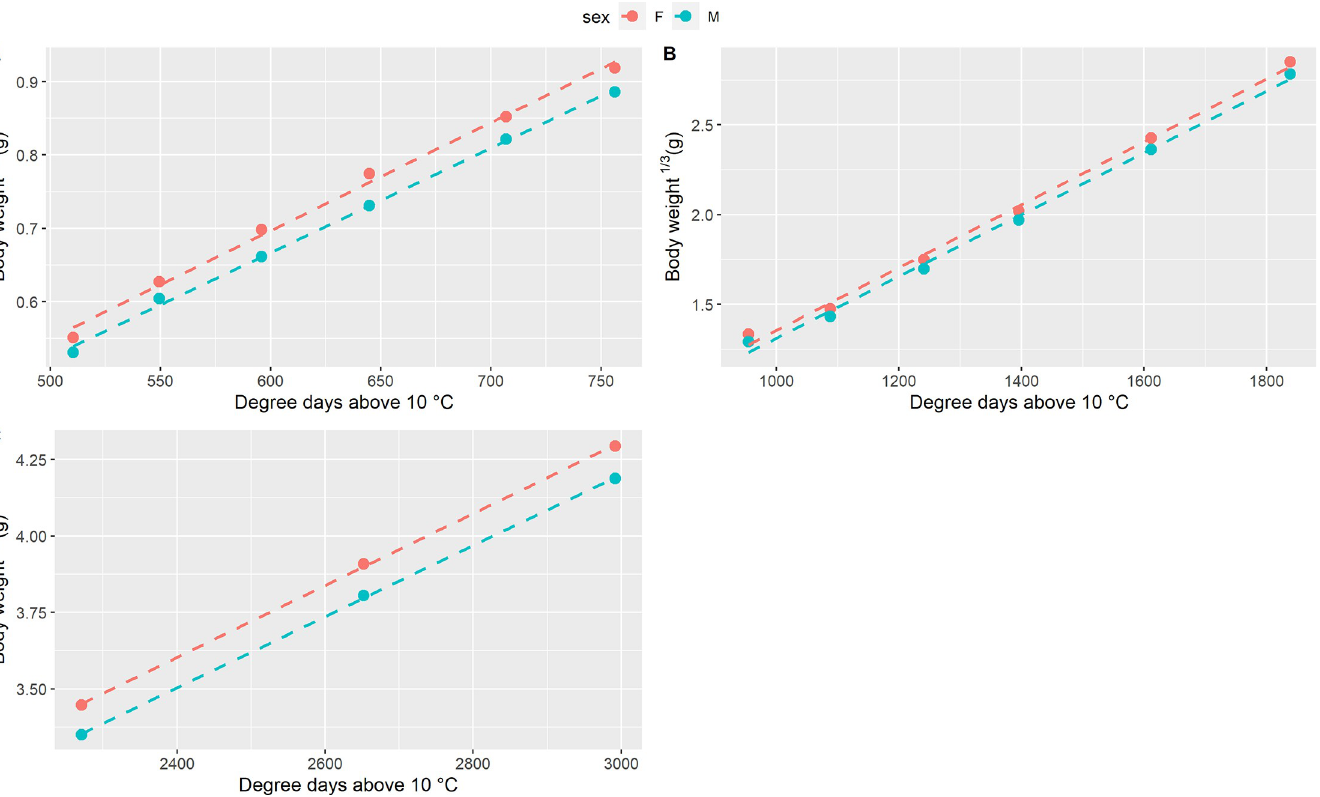
Fig 2. Growth curve for body weight. Body weight growth curve for females (F) and males (M) in the three growth periods: A) from 83 to 117 dph (510 to 756 degree days); B) from 137 to 223 dph (756 to 1838 degree days); C) from 265 to 335 dph (2271 to 2992 degree days).